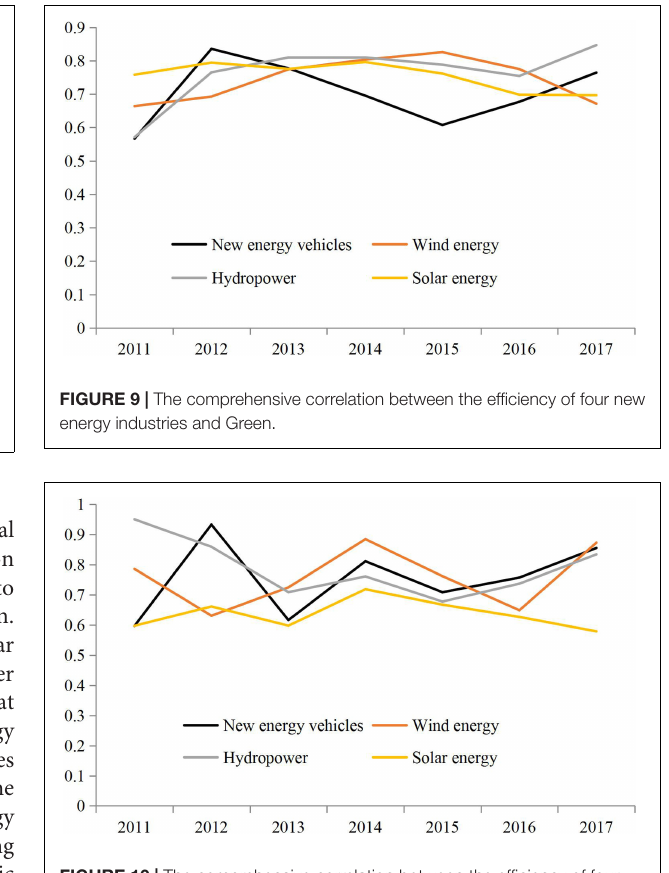
FIGURE 10 | The comprehensive correlation between the efficiency of four new energy industries and